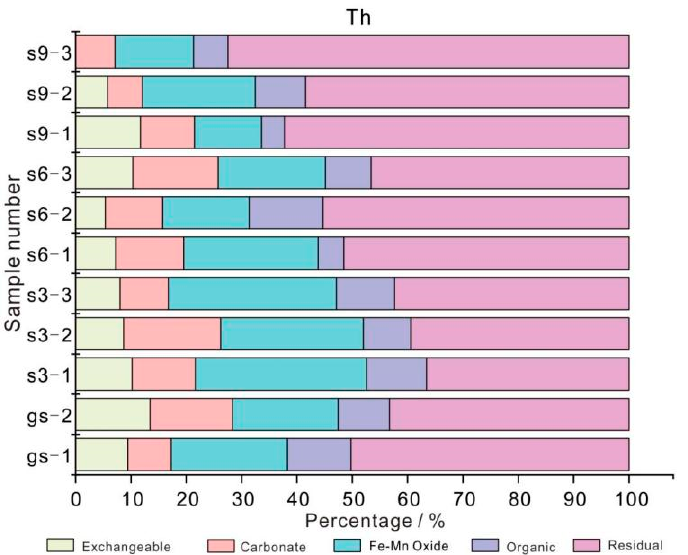
Figure 6. The modes of occurrence for Th element in coal gangue and soil profile. The modes of occurrence for Th element in the three soil profile samples (s3, s6, and